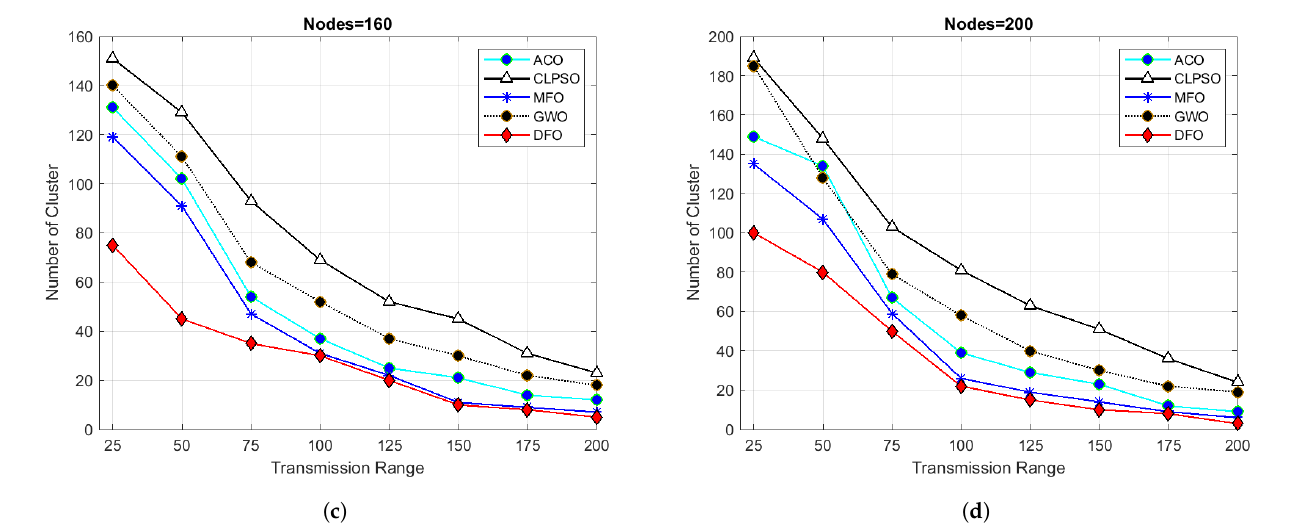
Figure 9. Grid size 1000 m × 1000 m and transmission range from 25 to 200.